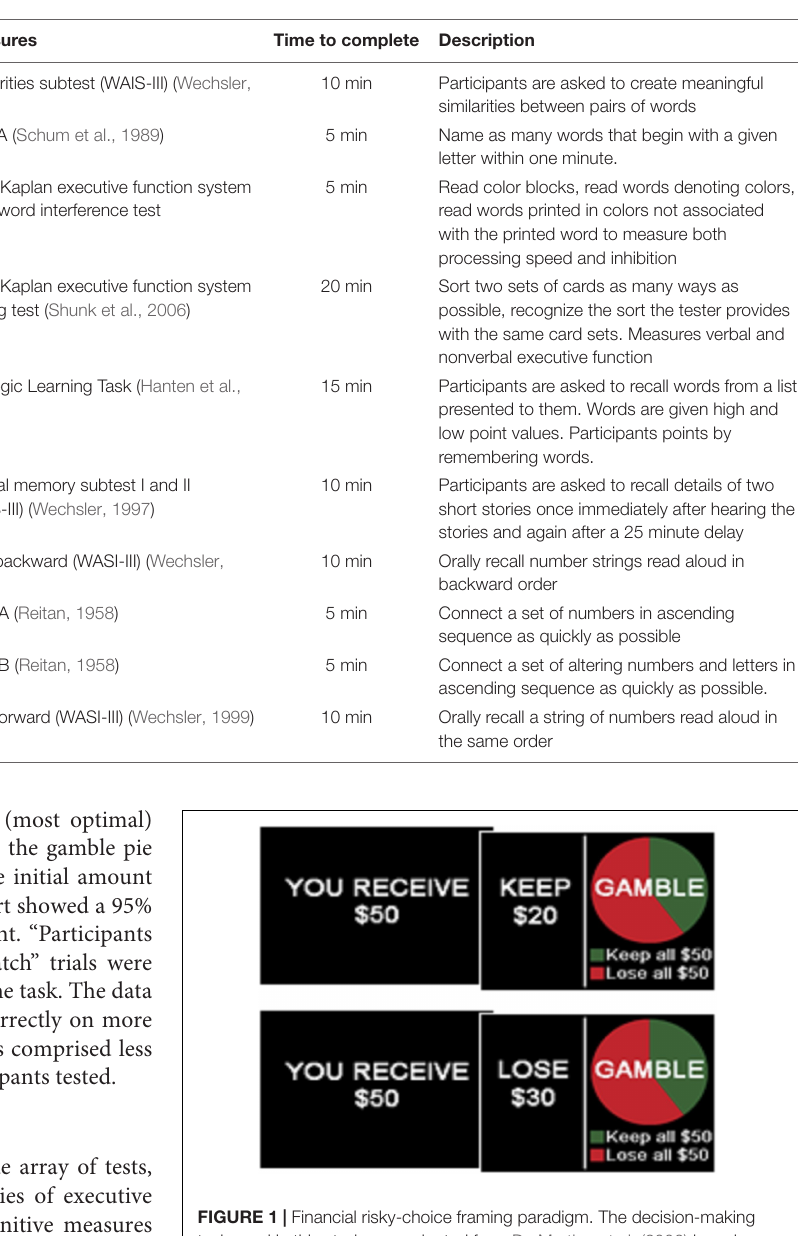
TABLE 2 | Measurements of cognition.